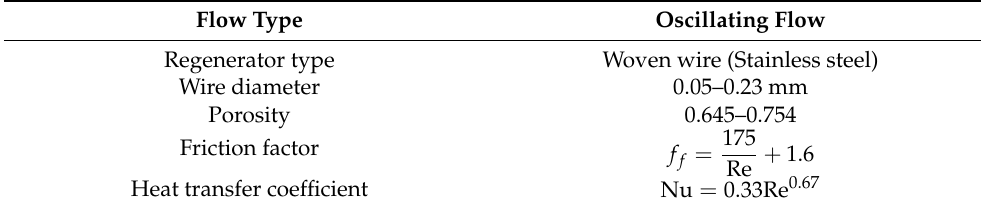
Table 8. Correlation equations of the regenerator